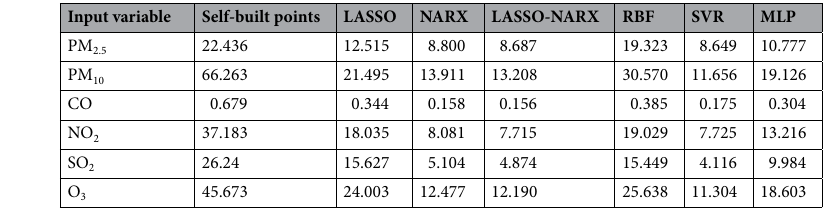
Table 5. RMSE of six types of air pollutant concentrations between self-built points, model forecast values and national control point.